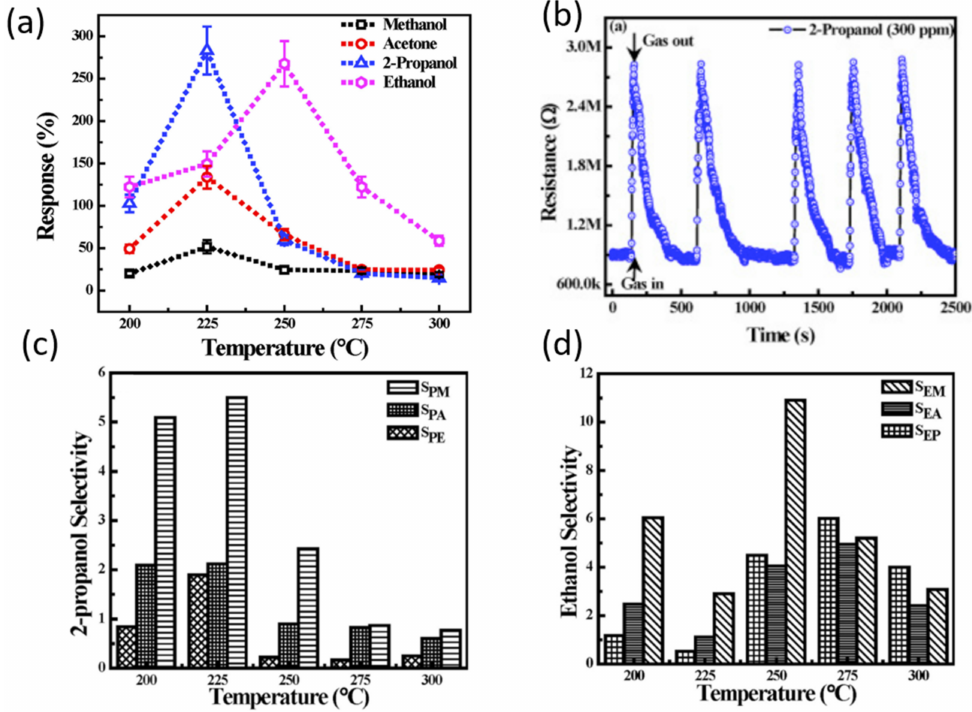
Figure 16. The sensing performance of CuO thin films. ( a ) The response, ( R gas − R air 300 ppm of several VOCs at different temperatures, where R gas and R air are the resistances measured in presence of gas and air, respectively. ( b ) The repeatability of CuO sensor towards 300 ppm of 2 propanol at 300 °C. ( c , d ) the selectivity study of 2 propanol and ethanol over other VOCs. Subscripts P, M, A, and E refer to propanol, methanol, acetone, and ethanol, respectively. Reprinted with permission from